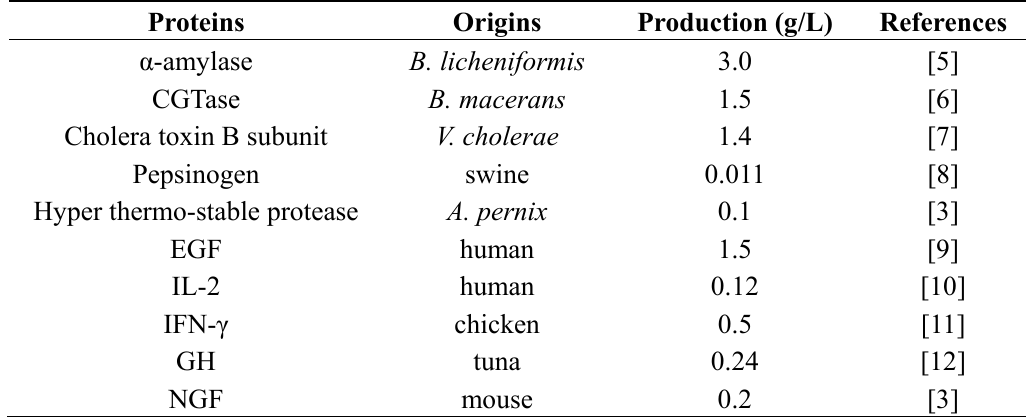
Table 1. Examples of the successful production of recombinant proteins by the Brevibacillus expression system.